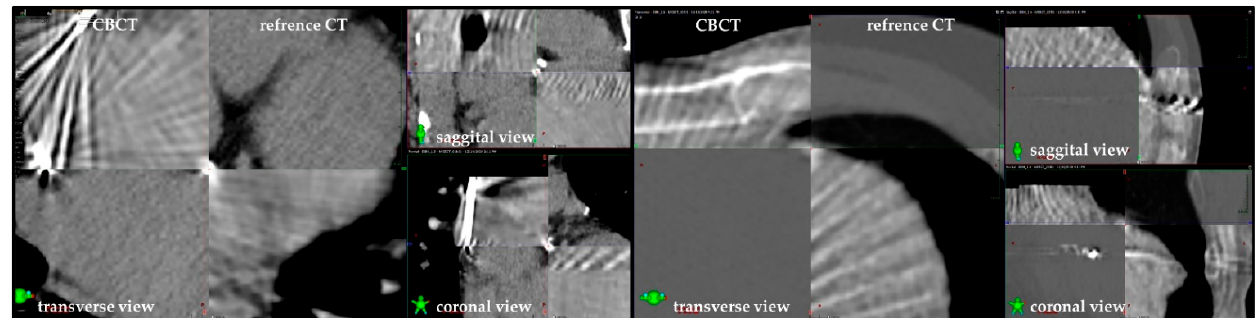
Figure 3. Pre-treatment cone beam CT (upper-left and lower-right parts) fused with treatment planning CTs. High-density reference points facilitate precise image-guided radiotherapy, despite significant artifacts caused by the Implantable Cardioverter Defibrillator lead.